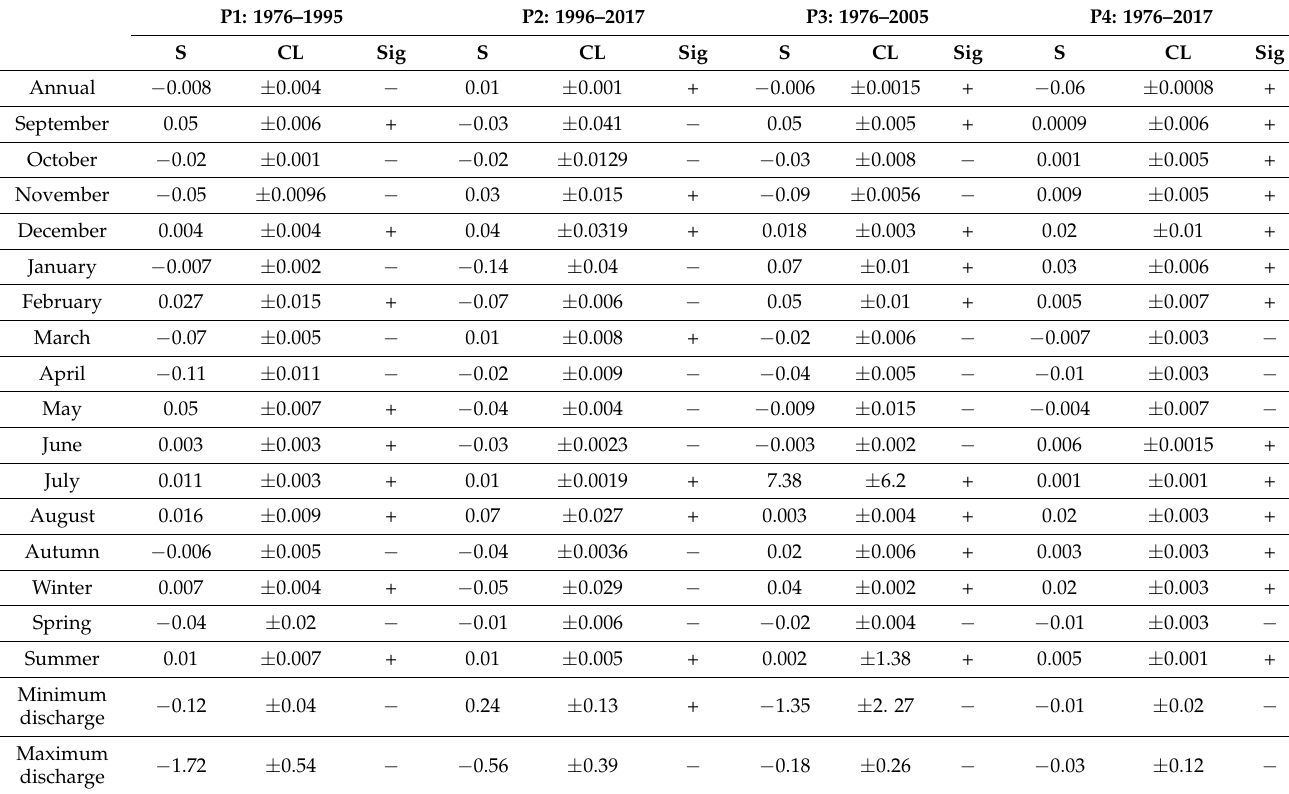
Table 4. Trend analysis using the ITA method for downstream of the Merguellil watershed (Haffouz station), m 3 /s. P1: